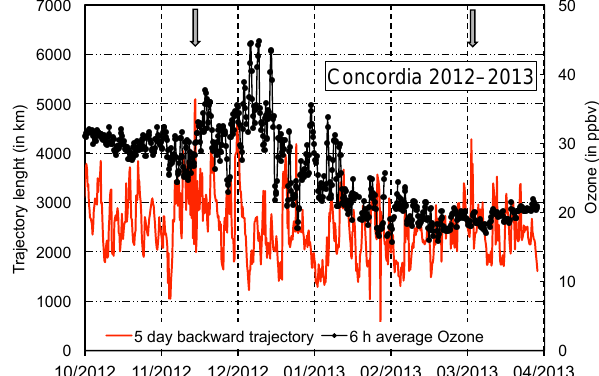
Figure 4. The 6h averaged ozone mixing ratio and distance cov- ered by the corresponding 5-day backward trajectory at Concordia (arrival at 0ma.g.l.) from spring 2012 to fall 2013. The two grey arrows refer to the days 14 November and 5 March for which the air masses arriving at Concordia had traveled over the ocean (see Sect. 3.1.1).